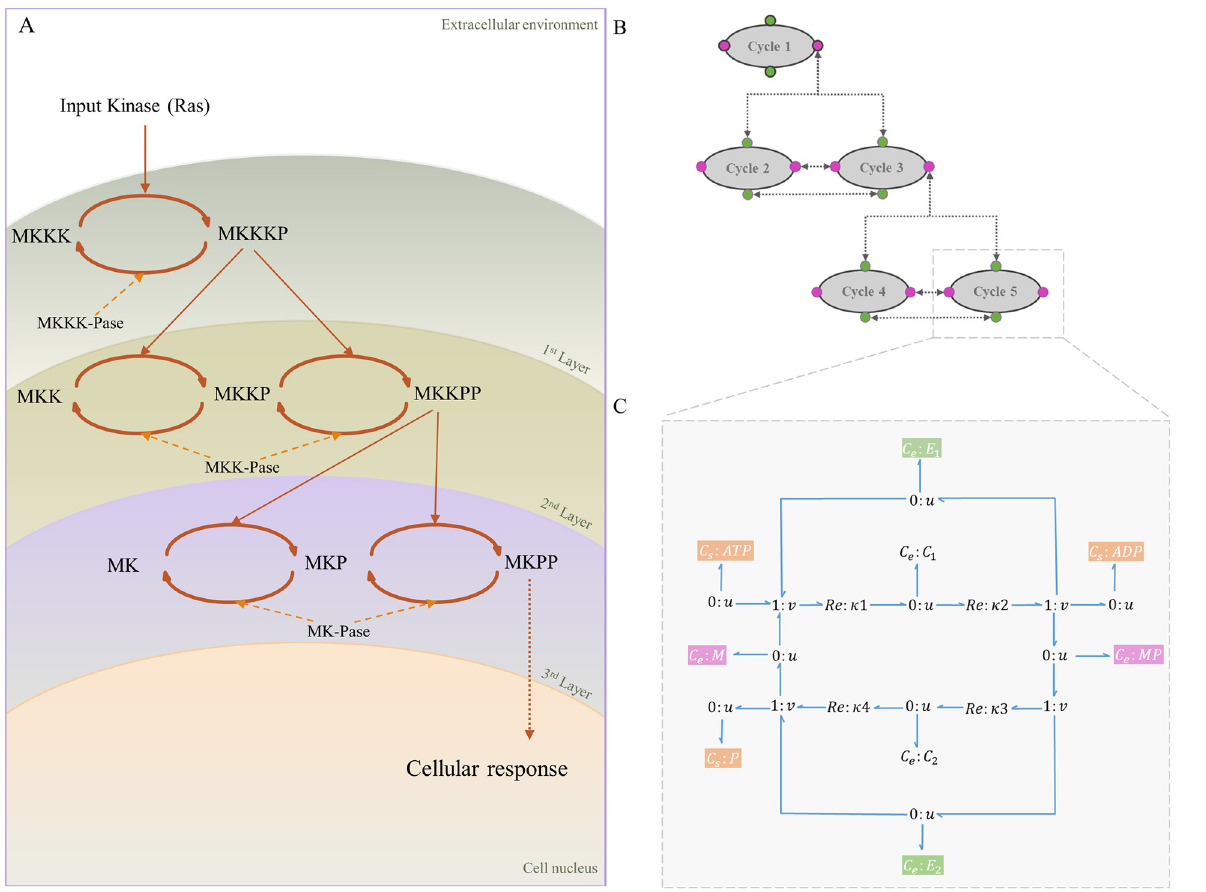
Fig 6. The structure of the MAPK cascade. (A) Kinetic representation. The stimulus from the extracellular environment is received (Ras) and transmitted through the MAPK cascade to the cell nucleus. The layers demonstrate the cycles with the same kinase and phosphatase enzymes; (B) MAPK cascade with five modules. Linking species are shown in colours where green corresponds to the linking enzymes and pink corresponds to unphosphorylated/phosphorylated mitogen proteins. Arrows show the links between the modules; (C) The symbolic bond graph model of each cycle. Sources of potential with fixed concentrations ( C s :ATP, C s :ADP, and C s :Pi) are shown in orange. (Same sources of potential within the modules are omitted in (A) and (B) for clarity).